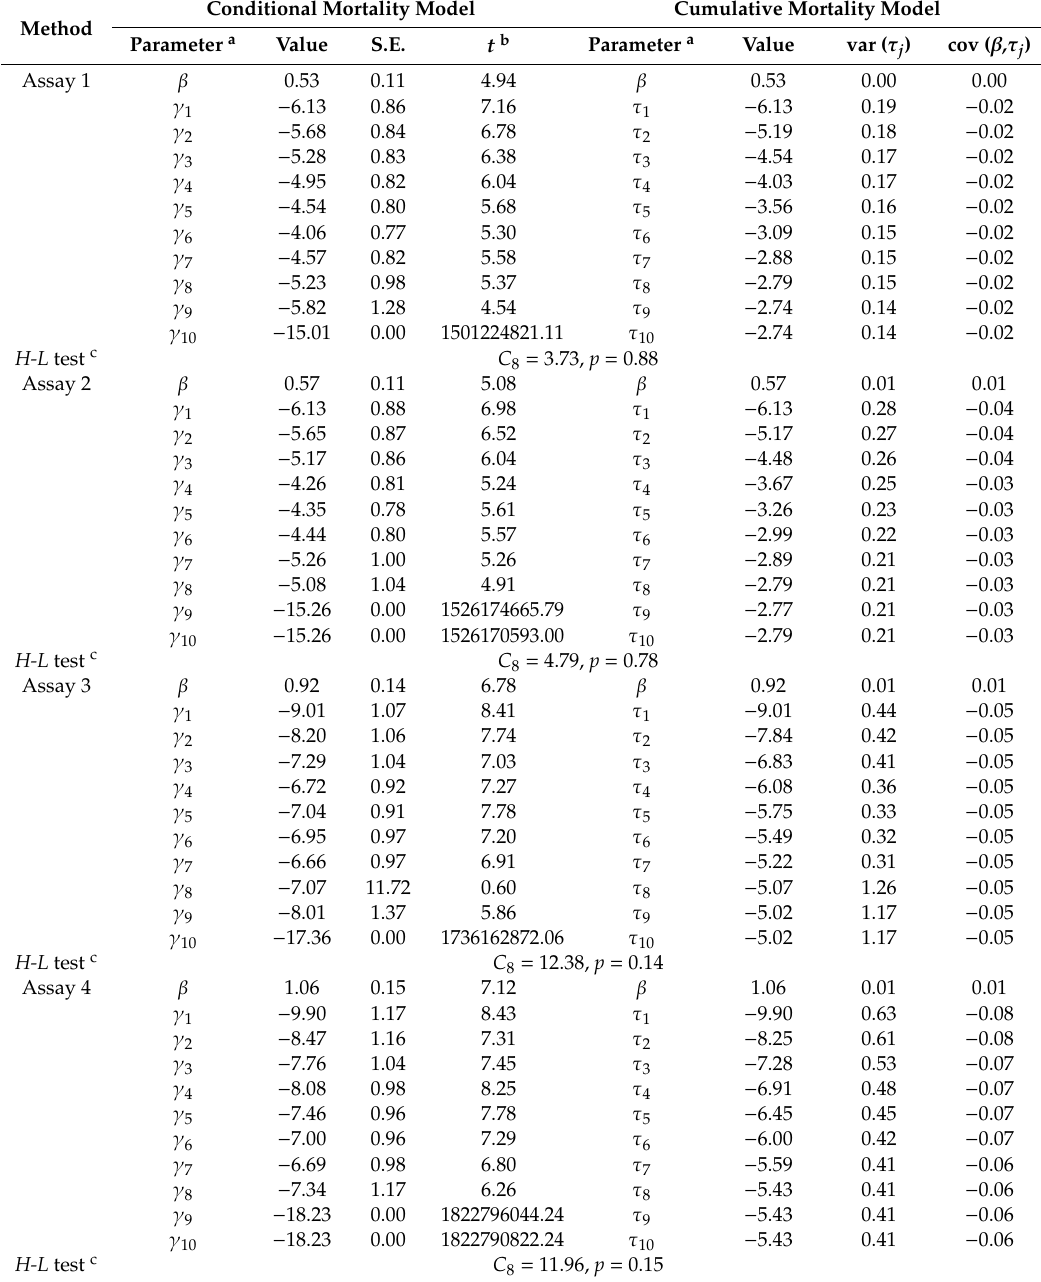
Table 2. Virulence parameters of M. flavoviride WSWL51721 against adult